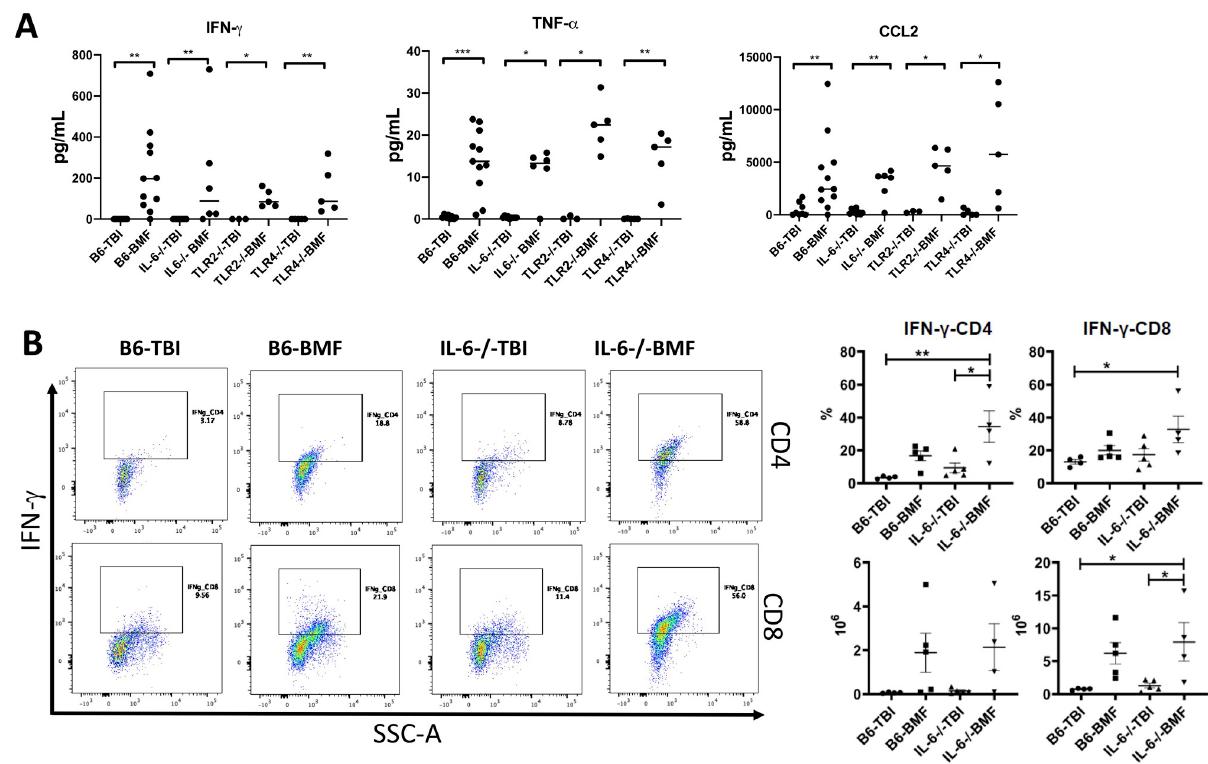
Fig 4. Inflammatory cytokines in B6, IL-6 -/- , TLR2 -/- , and TLR4 -/- recipient mice following FVB LN infusion. A. IFN- γ , TNF- α , and CCL2 levels in the plasma of B6 (N = 11), IL-6 -/- (N = 6), TLR2 -/- (N = 5), and TLR4 -/- (N = 5) recipient mice following FVB donor LN infusion as well as cytokines in their corresponding TBI control mice (N = 8, 9, 3, 5). The cytokines were measured by Luminex assay. B. Intracellular IFN- γ levels in CD4 + and CD8 + T cells in the BM of B6 (N = 5) and IL-6 -/- (N = 4) recipient mice as well as their corresponding TBI control mice (N = 4, 5) detected by flow cytometry. � , P < .05; �� , P < .01; ��� , P <